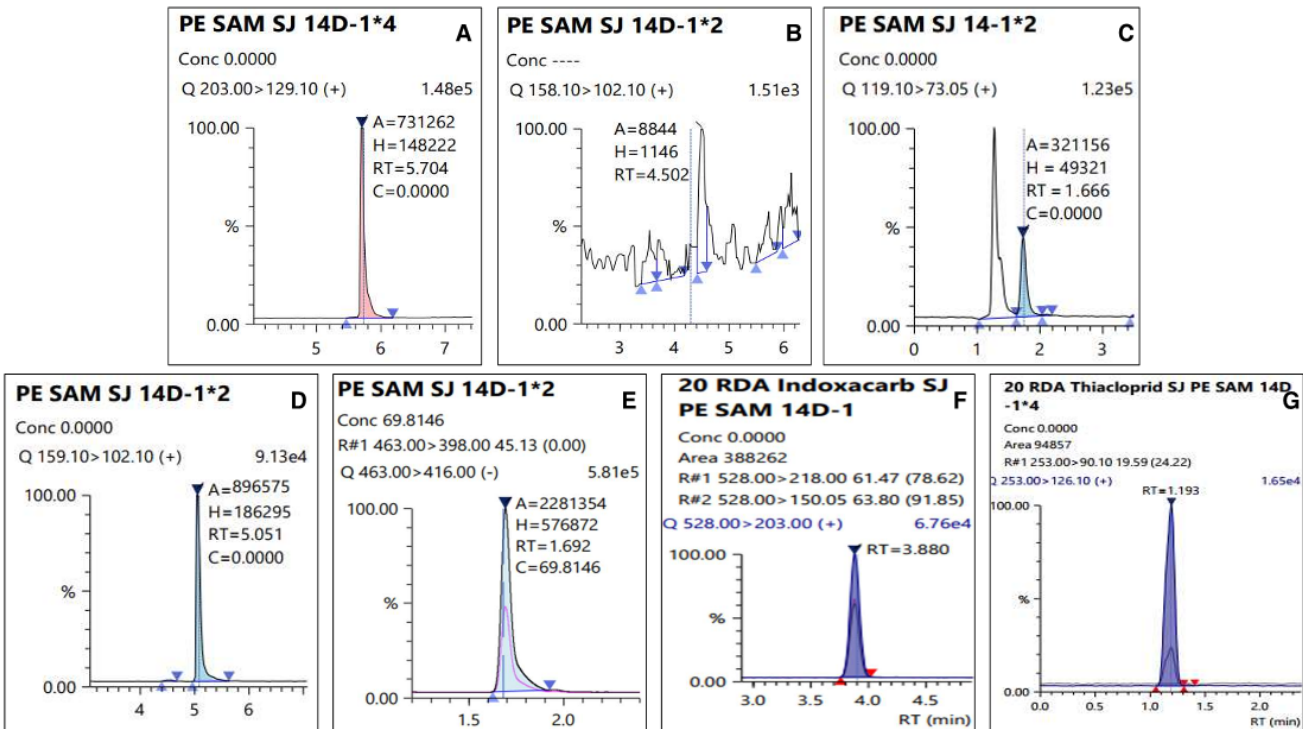
Figure 5. Chromatograms of residual pesticide in the fresh persimmon collected from site 2 on 14 day: ( A ) Dinotefuran (0.24 mg kg − 1 ), ( B ) DN (less than LOQ), ( C ) MNG (0.05 mg kg − 1 ), ( D )UF (0.03 mg kg − 1 ), ( E ) Fluazinam (0.14 mg kg − 1 ), ( F ) Indoxacarb (0.12 mg kg − 1 ), and ( G ) Thiacloprid (0.07 mg kg − 1 ).